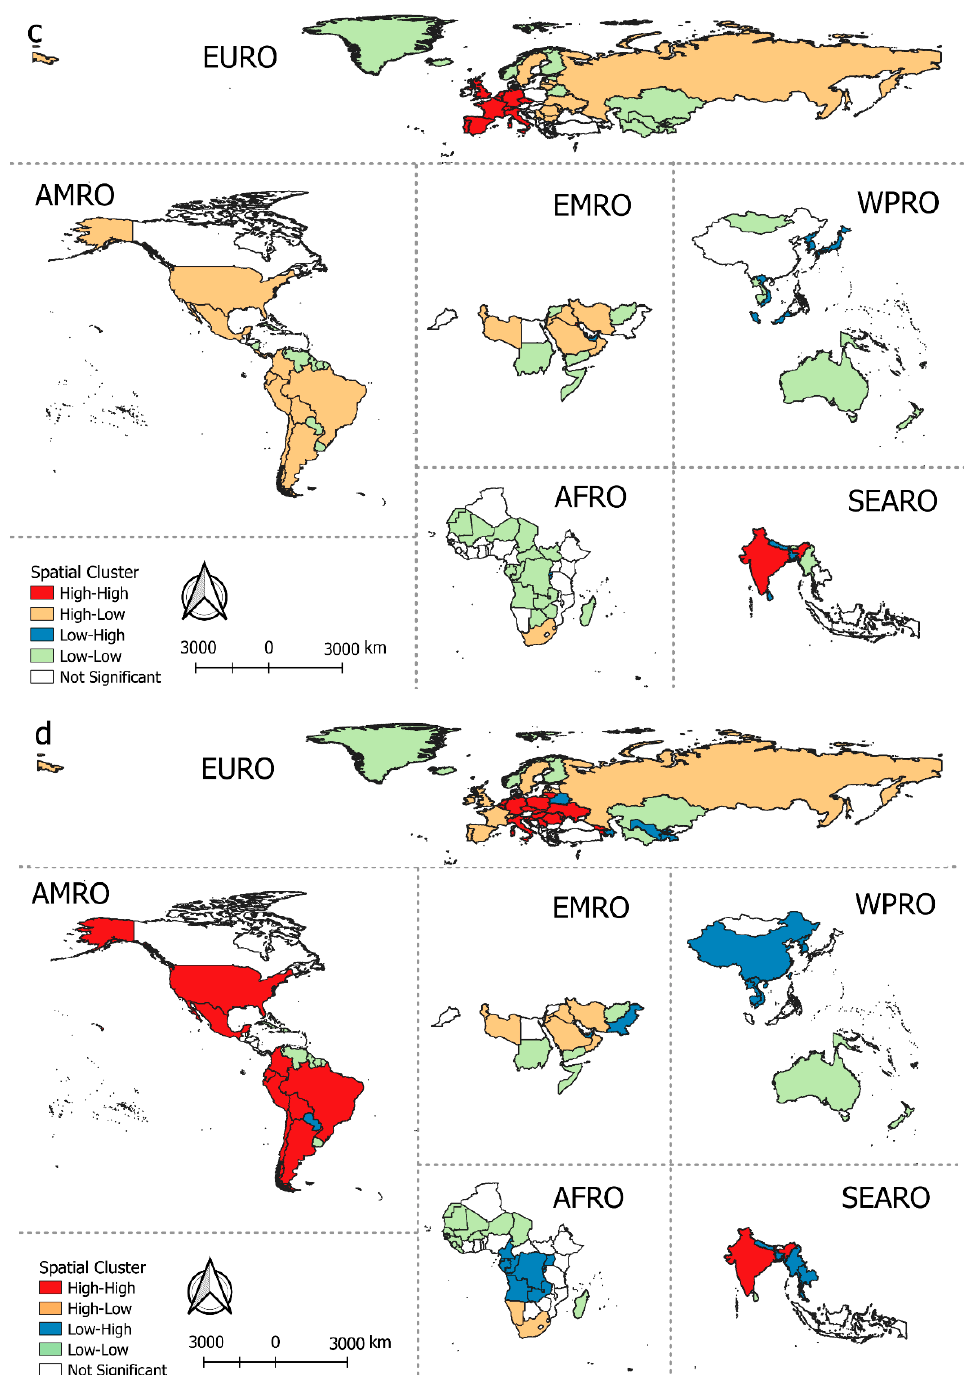
Figure 5. Bivariate local spatial association results: ( a ) cumulative confirmed cases per million population and population density; ( b ) cumulative confirmed cases per million population and PM 2.5 ; ( c ) cumulative deaths per million population and population density; ( d ) cumulative deaths per million population and PM 2.5 .